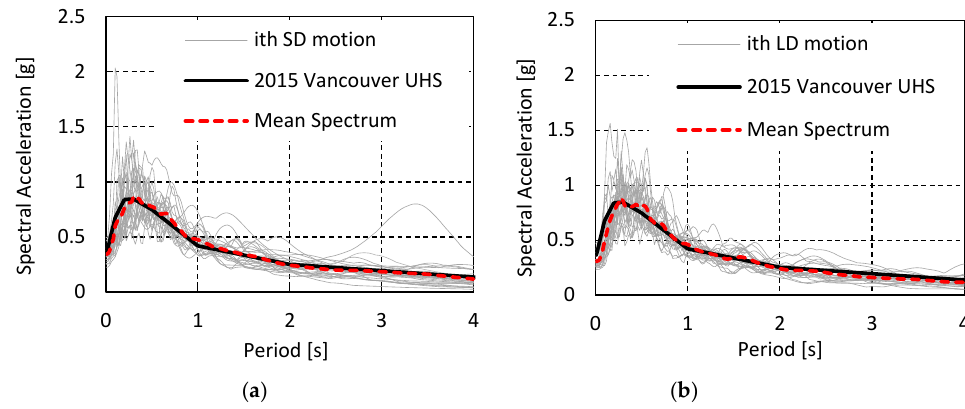
Figure 7. Response spectra of selected motions: ( a ) SD and ( b ) LD.